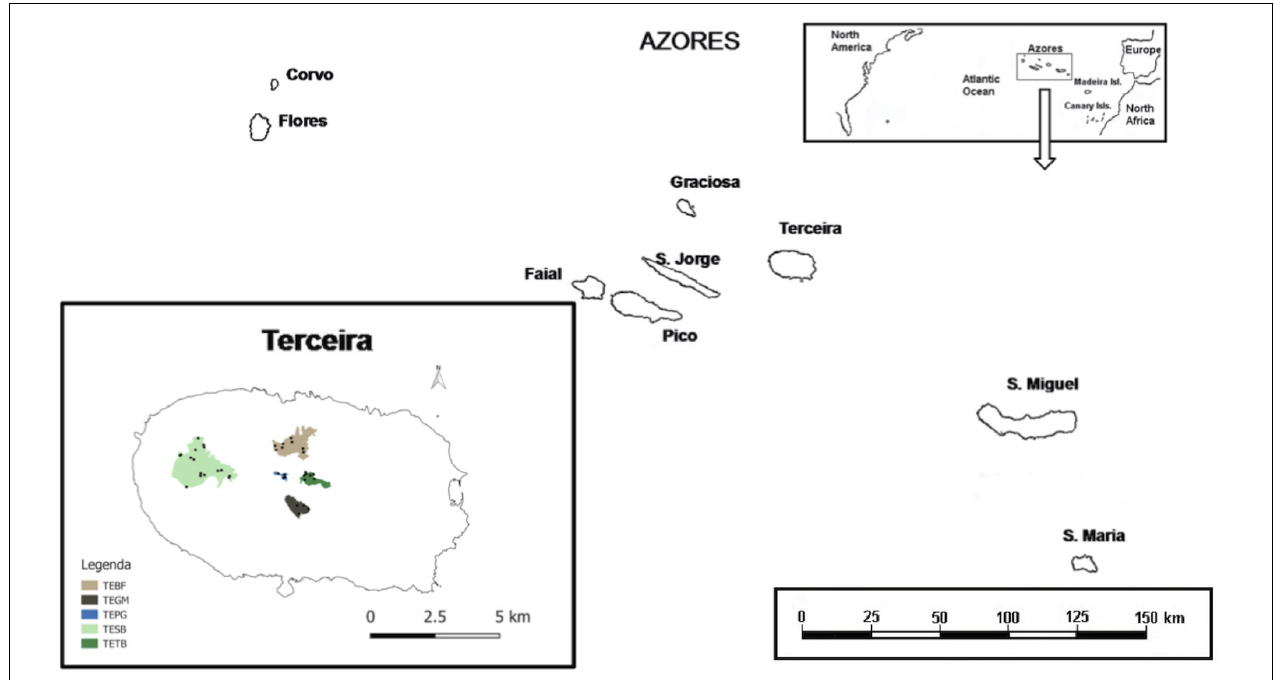
FIGURE 1 | The Azorean archipelago with a detailed map of Terceira Island. The acronyms correspond to the following vegetation fragments: TEBF, Biscoito da Ferraria; TEGM, Guilherme Moniz; TEPG, Pico Galhardo; TESB, Santa Bárbara; TETB, Terra Brava. Maps were generated in Open Source QGis.